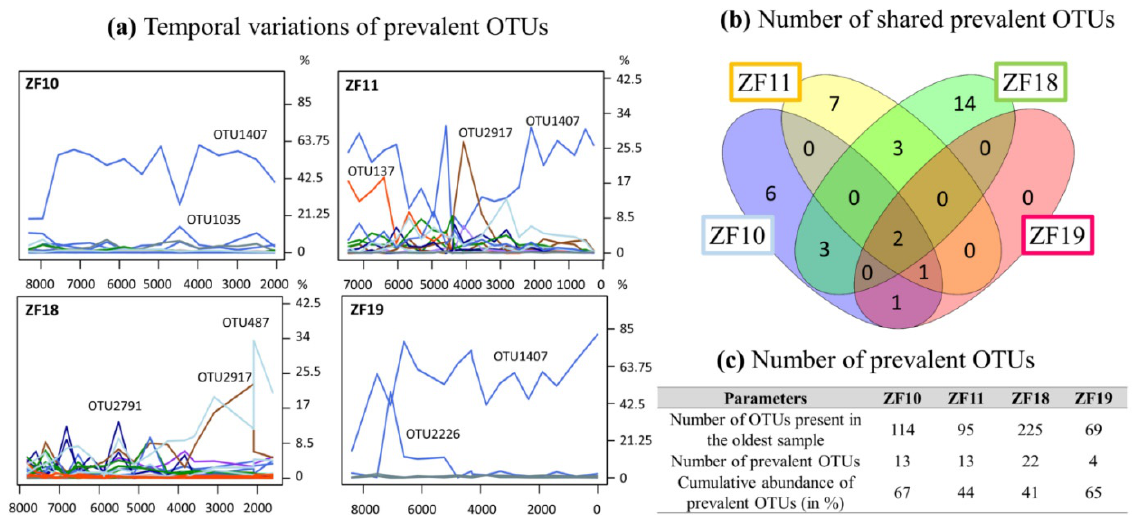
Figure 5. ( a ) Temporal changes in the relative abundance of the prevalent OTUs for each lake. This number of DNA reads from each prevalent OTU corresponds to their relative abundance for each sample rarefied at 23,500 DNA reads. ( b ) Number of shared prevalent OTUs. ( c ) Number of prevalent OTUs.